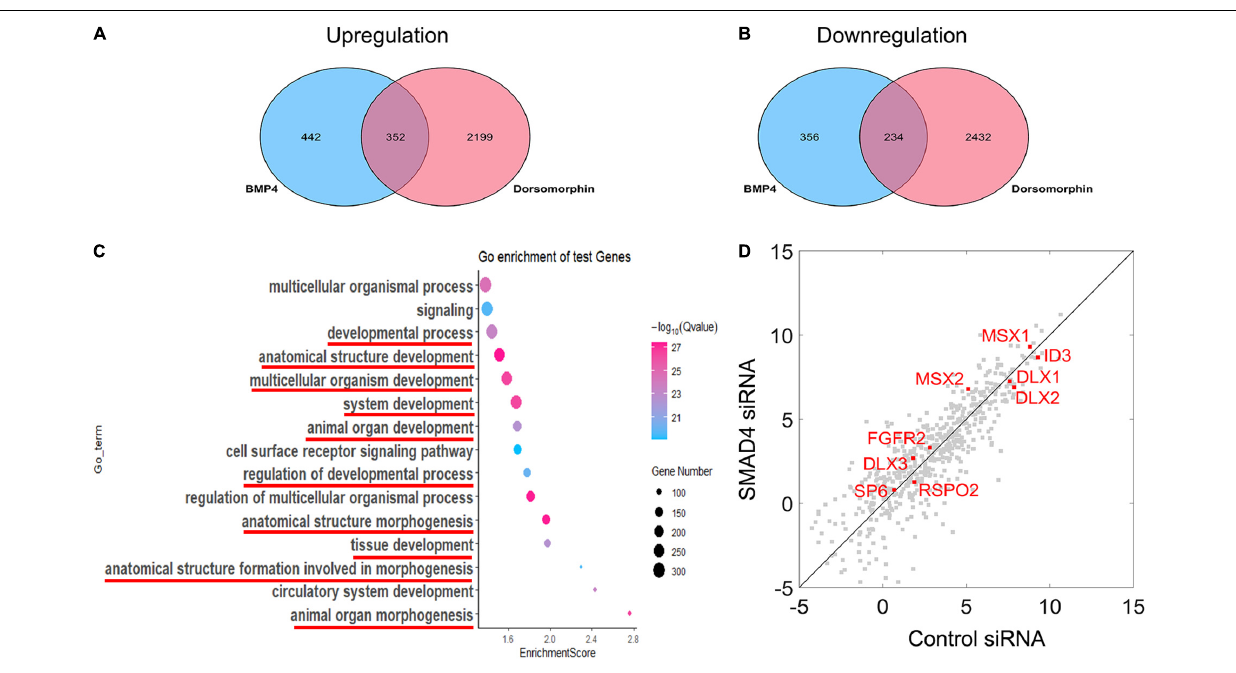
FIGURE 5 | RNA-Seq analysis reveals that the modulation of BMP/pSMAD1/5/8 is SMAD4-independent. (A,B) Venn diagram showing the overlap between BMP4-induced and dorsomorphin-inhibited mRNA transcripts and the mRNA ≥ 1 × changed in hDMCs. (C) Gene ontology analysis shows that the upregulated and downregulated genes are primarily involved in development and morphogenesis (red line). The scatterplot reveals differences in transcript abundance between control siRNA-treated hDMCs and SMAD4 siRNA-treated hDMCs. (D) Transcript levels are log2 transformed. The genes that have been demonstrated to be crucial in tooth development and their regulatory domains (promoters) are directly bound by pSMAD1/5/8 as well are indicated in